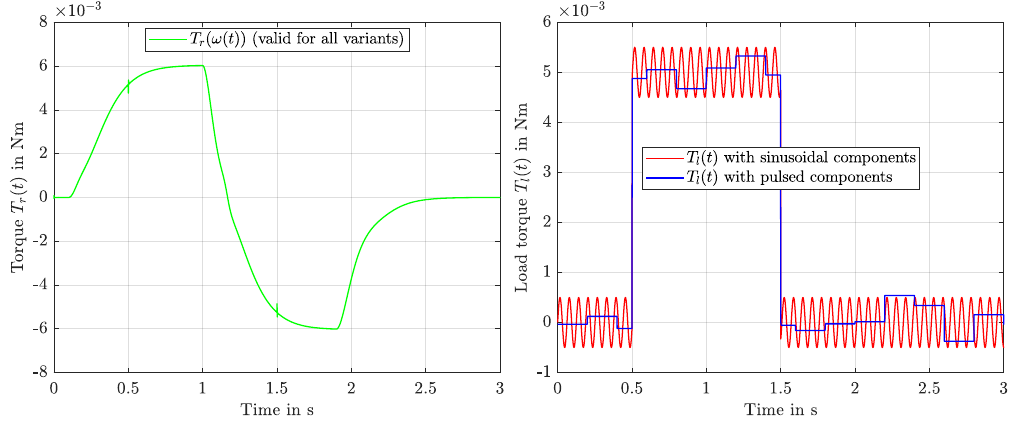
Figure 3. Friction torque T r ( left ) and load torque T l ( right ).